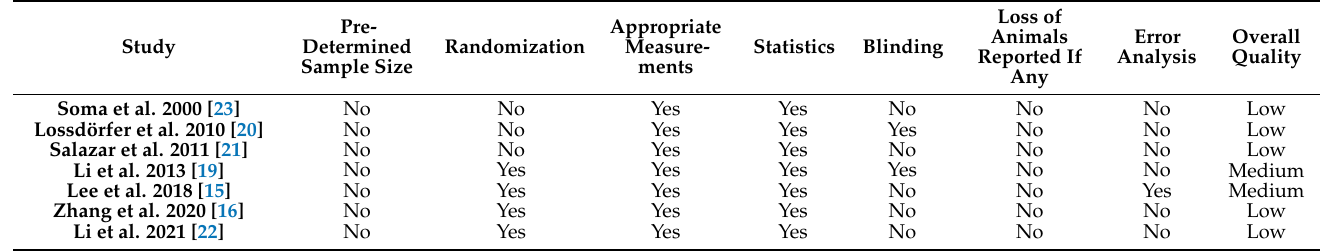
Table 2. Results of the quality